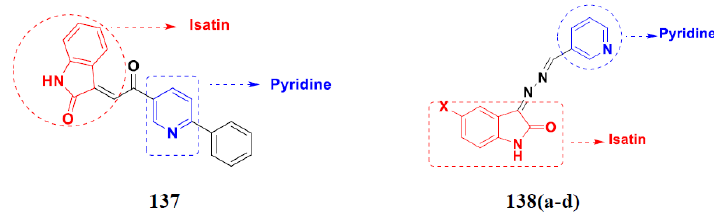
Figure 126. Structure of isatin ‐ pyridine derivative [ 137 , 138 ( a – d )]. Table 113. In vitro cytotoxic activities of isatin ‐ pyridine hybrid compounds [ 137 , 138 ( a – d )]. Compounds